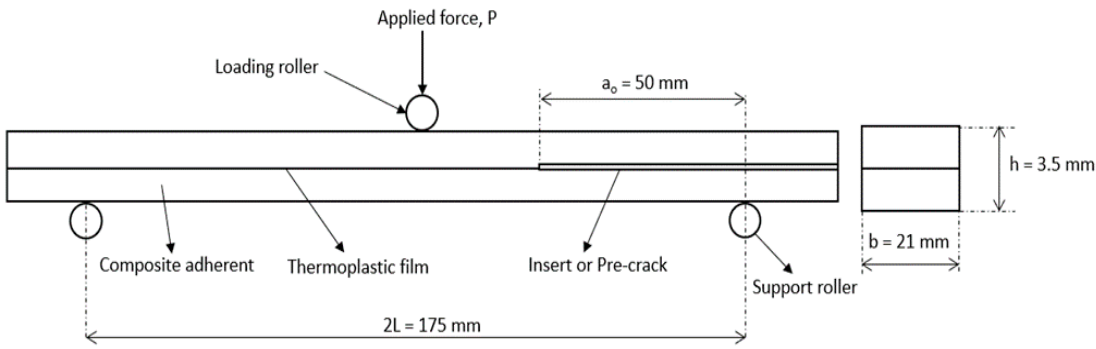
Figure 6. Schematic of ENF specimen.